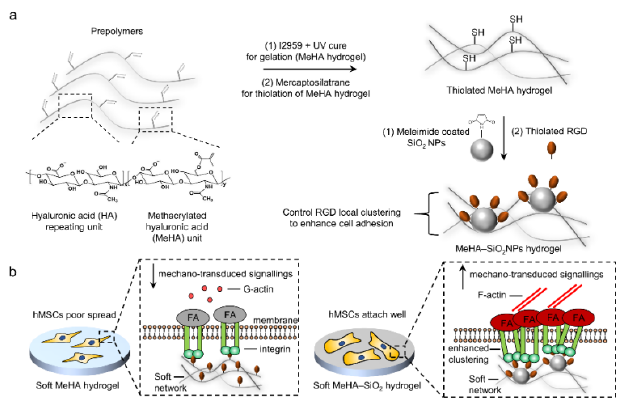
Figure 1. Schematic illustration of integrating nanostructures into soft hyaluronic acid (HA) hydrogel for enhancing human mesenchymal stem cell (hMSC) adhesion. ( a ) Synthetic routes of methacrylated HA (MeHA) hydrogel with cell-adhesive ligands (RGD)-bearing silica nanoparticles (SiO 2 NPs) conju- gation, forming nanocomposite hydrogel (MeHA–SiO 2 ). ( b ) proposed mechanisms of differential cell behaviours on bare soft MeHA hydrogel ( left ) and soft MeHA–SiO 2 hydrogel ( right ),